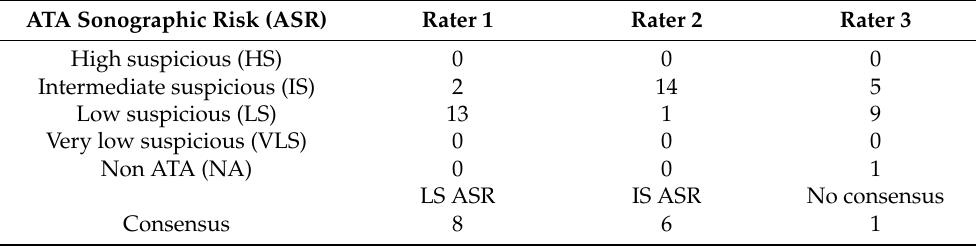
Table 4. Nodules with disparity between higher (HS + IS) and lower risk (L + VL) ASR categories as interpreted by each rater (n = 15).